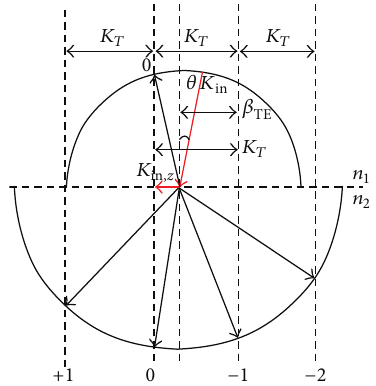
Figure 3: Wave-vector diagram for the grating